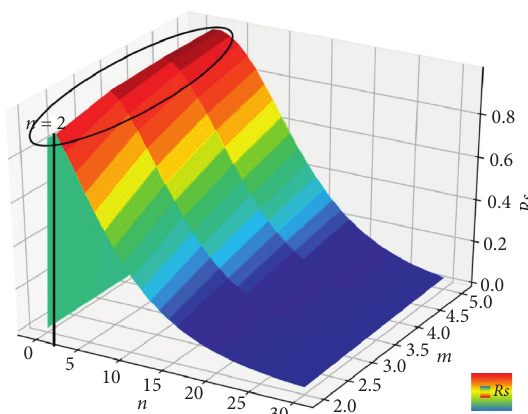
Figure 8: Curve of the reliability of tandem system changing with parameter n